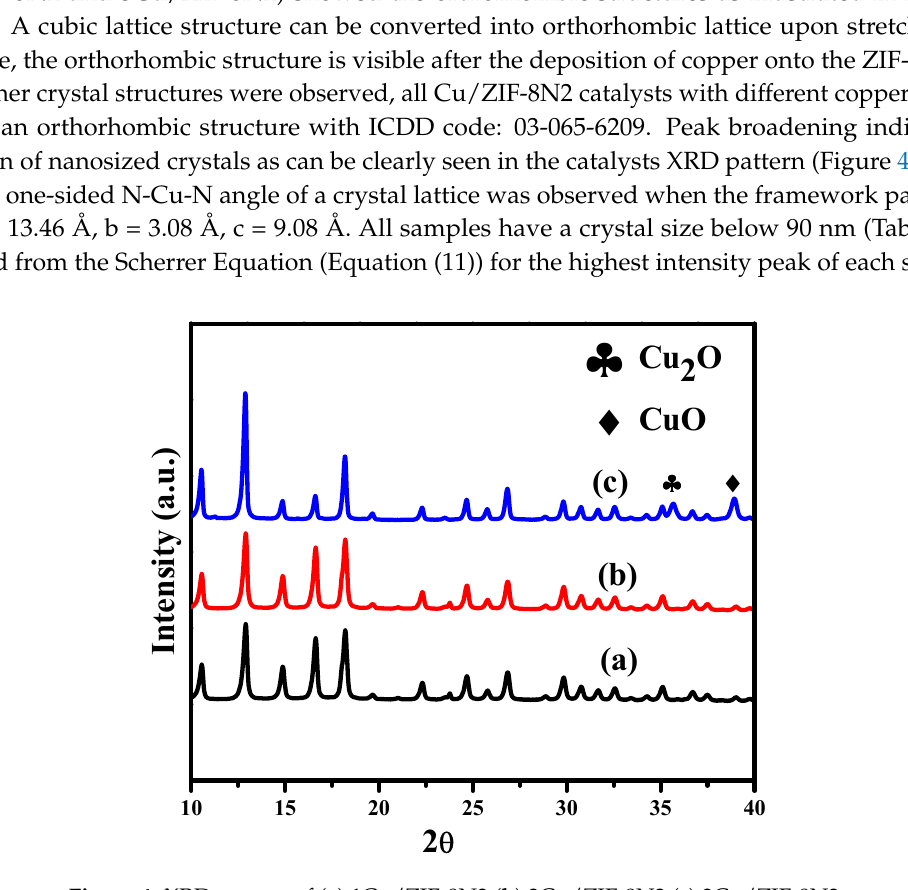
Figure 4. XRD spectra of ( a ) 1Cu/ZIF-8N2 ( b ) 2Cu/ZIF-8N2 ( c ) 3Cu/ZIF-8N2.